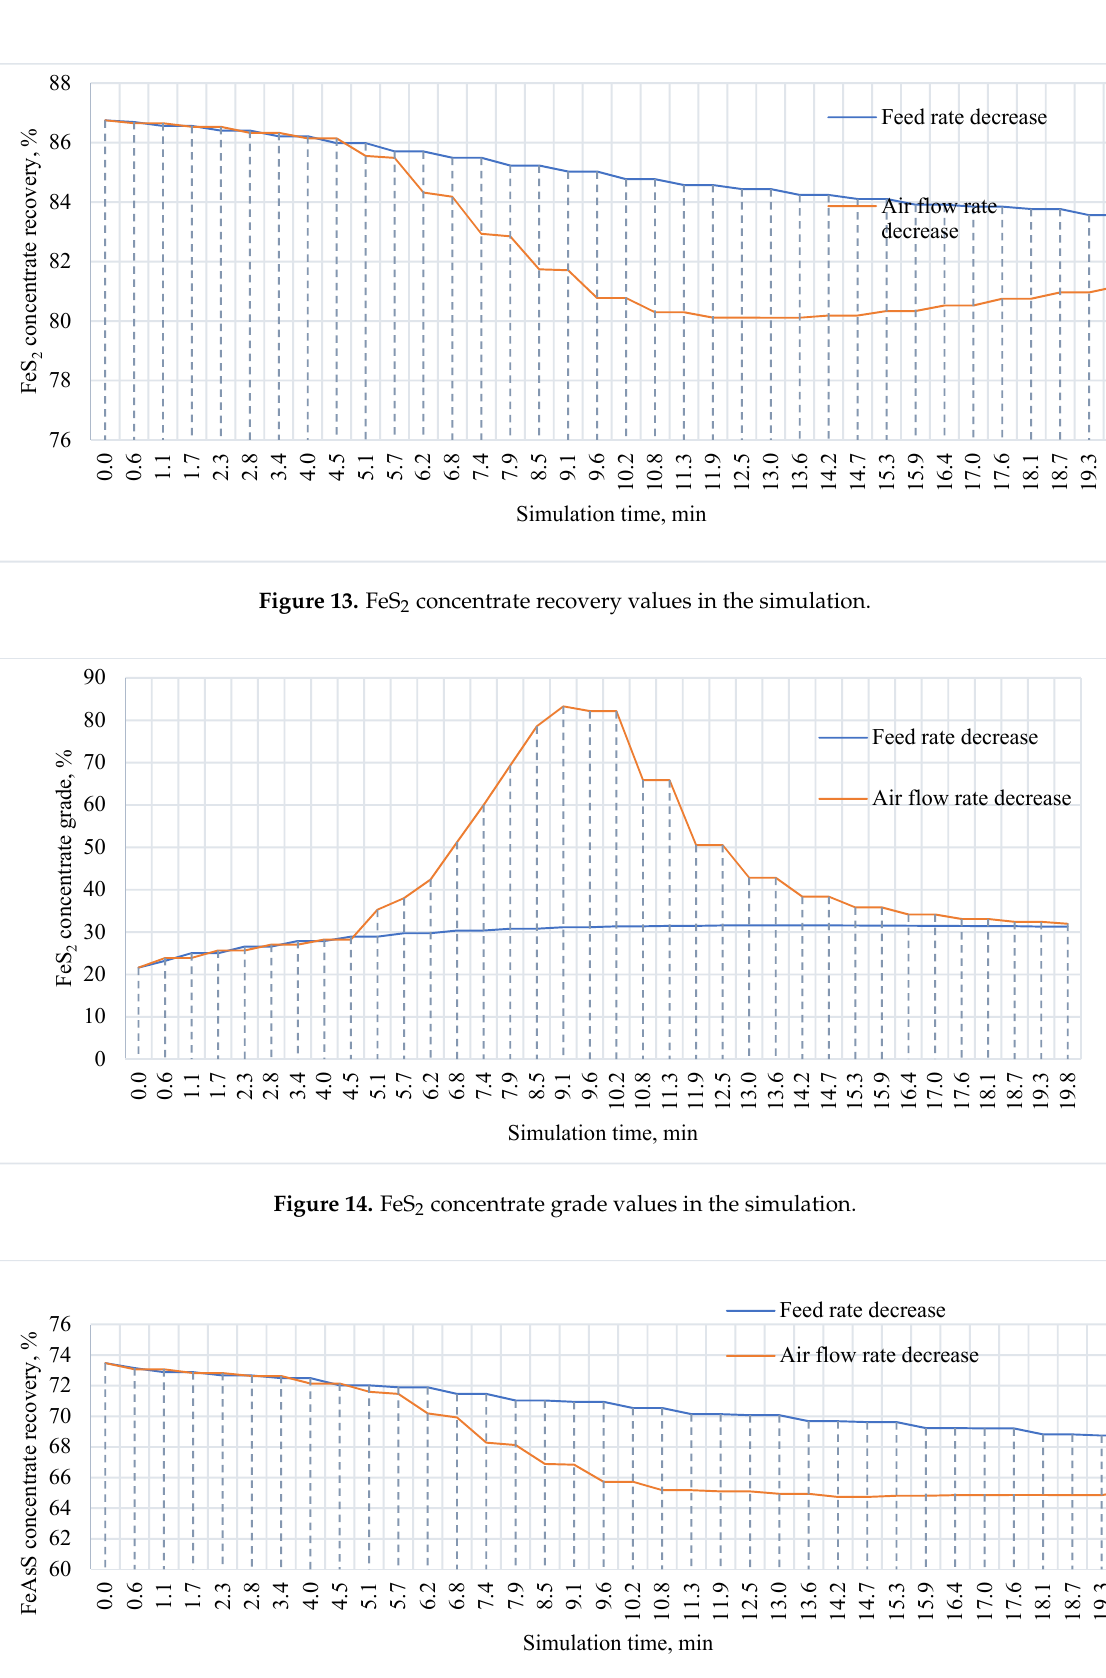
Figure 16. FeAsS concentrate grade values in the simulation. Through the results of the simulation, it is established that, at an interval from 0 min till 4.5 min, the difference in the responses on the change in parameters is insignificant. At 4.5 min of the simulation, there is a sharp decrease in the foam layer height with a decrease in the air flow rate, which entails a sharp increase in the content of valuable components and a drop in their recovery to the froth. However, at the end of the simulation, the dif- ference in the valuable component content for both investigated scenarios is insignificant, where the difference in extractions for pyrite is 2.39% and for arsenopyrite is 3.58%. This is due to the effect of an uneven reduction in the degree of the aeration of the pulp. With a decrease in the air flow rate, there is a decrease in the stability and height of the foam layer. In the foam zone, the non-uniformity of the water content over the layer height is created, which reduces the carrying capacity of the foam. Thus, only opened clusters of valuable minerals are carried into the concentrate. However, after the water content values equalize along the height of the foam layer, the content values return to the initial ones. At the same time, reducing the air flow rate reduced the value of the height at which the foam can be stable. This is associated with the yield of the concentrate and the possible extraction of valuable components. The obtained results should be taken into account when implementing control and automation systems for flotation processes. Reducing the power supply to the process does not lead to a violation of the stability of the process. In this case, a change in techno- logical indicators occurs smoothly. At the same time, when changing the air flow rate, there are noticeable violations of the dynamics of the process, and it takes time to return to the steady state.